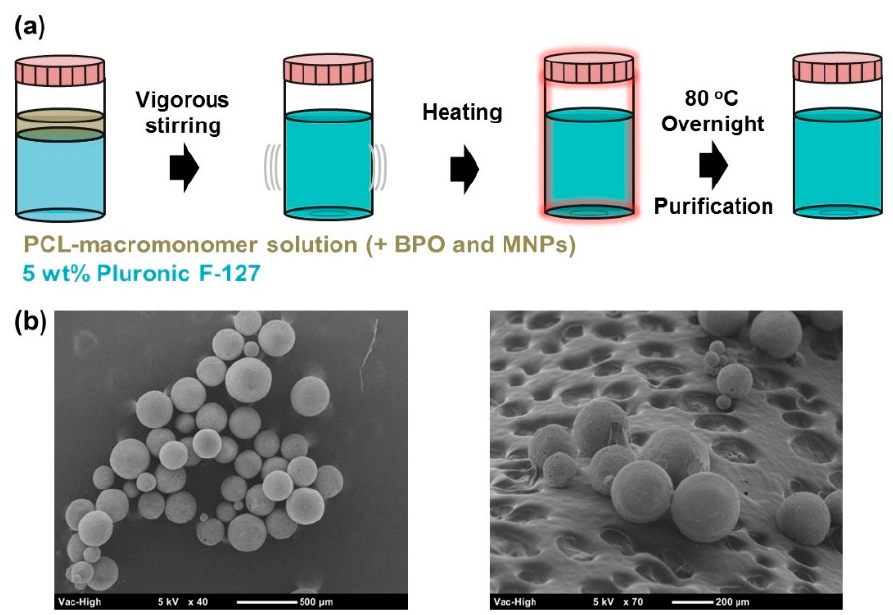
Figure 1. ( a ) Schematic illustration of preparation procedure of shape-memory PCL microparticles by in-situ oil-in-water (o/w) emulsion polymerization technique; ( b ) Top view (Left) and tilt view (Right) SEM images of prepared shape-memory PCL microparticles with acceleration voltage of 5 kV. Scale bars, 500 µ m (Left) and 200 µ m (Right).